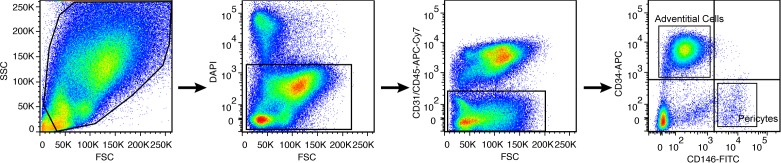
Human PSC derivation by fluorescence activated cell sorting.From left to right: Perivascular stem cells are derived by size distribution, followed by exclusion of DAPI+ cells, followed by exclusion of CD31 or CD45 expressing cells. Finally, microvascular pericytes (CD146+CD34-) and adventicytes (CD146-CD34+) cells are isolated and combined to constitute a bipartite perivascular stem cell population.